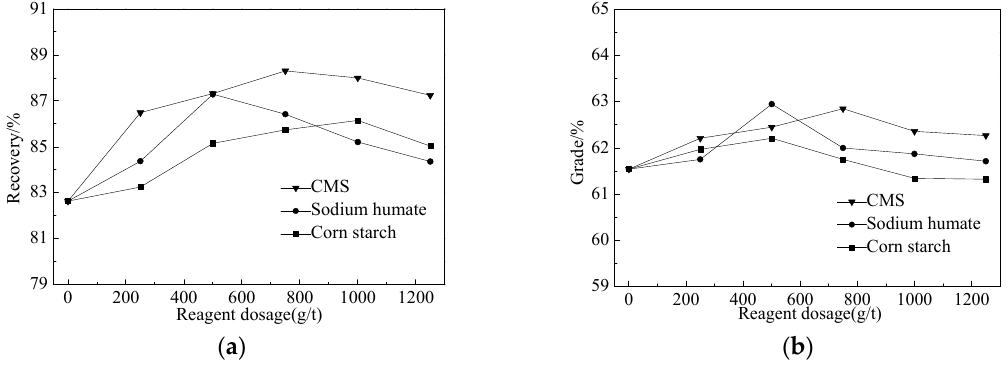
Figure 9. The effects of flocculant types and amounts on concentrate. ( a ) Iron recovery; ( b ) Iron grades.